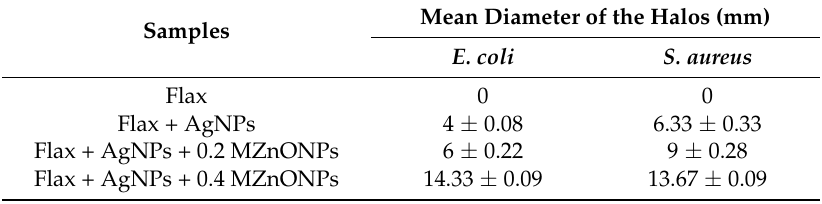
Figure 9. Antibacterial activity of flax ( A ), flax + AgNPs ( B ), flax + AgNPs + 0.2 MZnONPs ( C ) and flax + AgNPs + 0.4 MZnONPs ( D ) for E. coli and S. aureus . Table 1. Inhibition zone diameter of functionalized flax fabrics against E. coli and S. aureus bacteria accordingly with the JIS L 1902–Halo Method. Values are represented by mean ± standard deviation of triplicates.